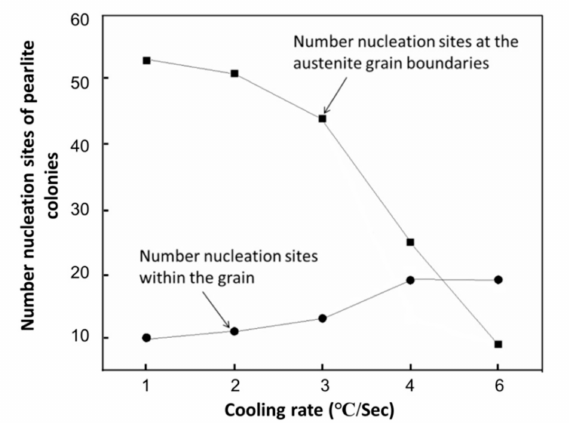
Figure 8. Number of nucleation sites of pearlite at di ff erent cooling rates in the area of 200 µ m × 190 µ m.